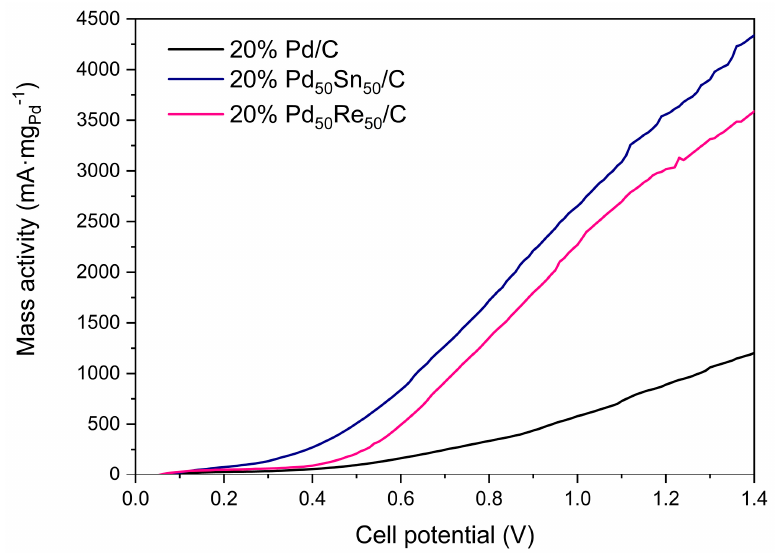
Figure 4. Membrane-less linear sweep voltammetry measurements (mass activity vs. cell poten- tial). Scan rate = 10 mV·s − 1 . Inlet composition = 1 mol·L − 1 EtOH and 4 mol·L − 1 KOH. T = 85